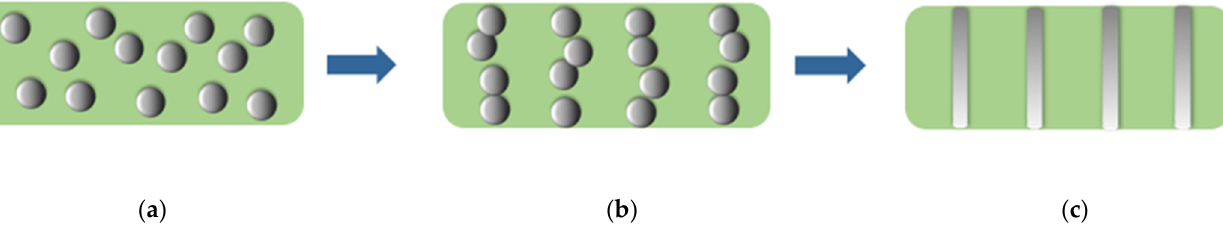
Figure 1. Different architectures of the ZnO/PMMA composite: ( a ) particles randomly dispersed; ( b ) aligned particles; and ( c ) vertically aligned NW arrays within the polymer matrix.